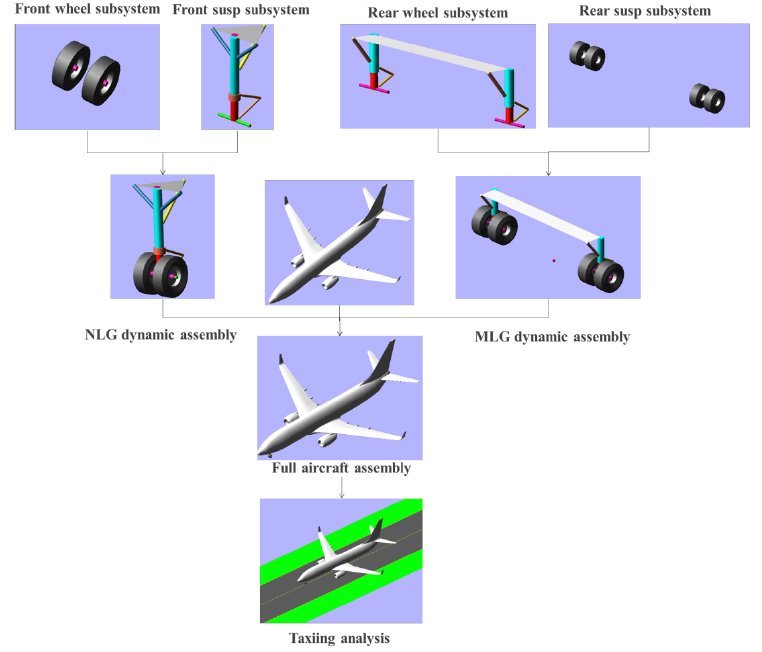
Figure 2. Iconic flowchart of the modeling and assembly process [10].